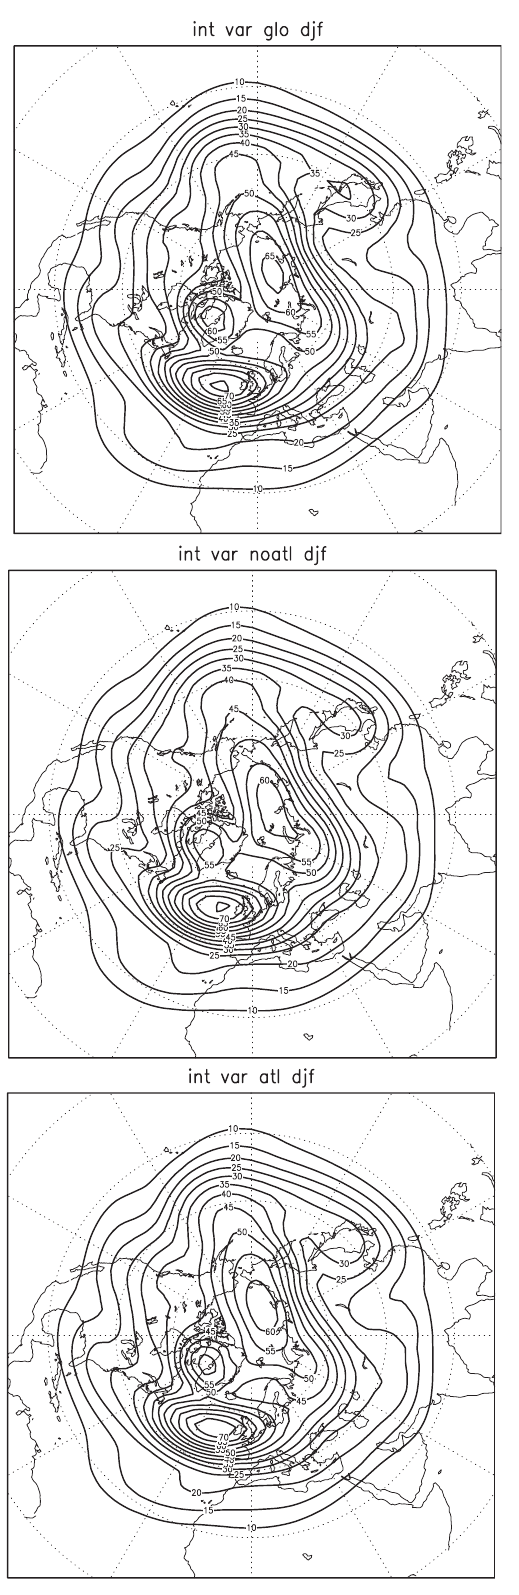
Fig. 2. Same as in fig. 1, but for the internal varia- bility.